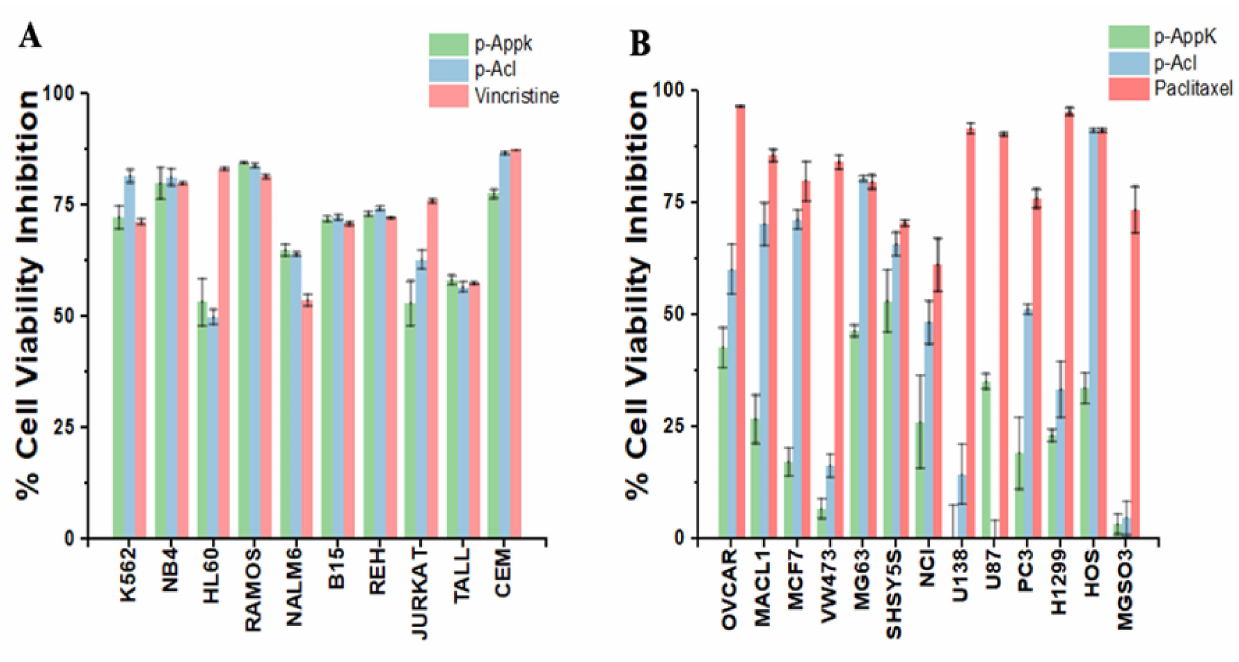
Figure 4. In vitro cytotoxicity of p-AppK (green) and p-Acl (blue). ( A ) Leukemia cell lines and ( B ) solid tumors were exposed to a concentration of 100 µ M of both peptides. A colorimetric assay determined the cell viability inhibition after 24 h of peptide treatment. Cells cultured in a growth medium without the peptides were considered a positive control with 100% viability. The positive control (reference antineoplastic drug) is represented in salmon. The data represent the mean ±